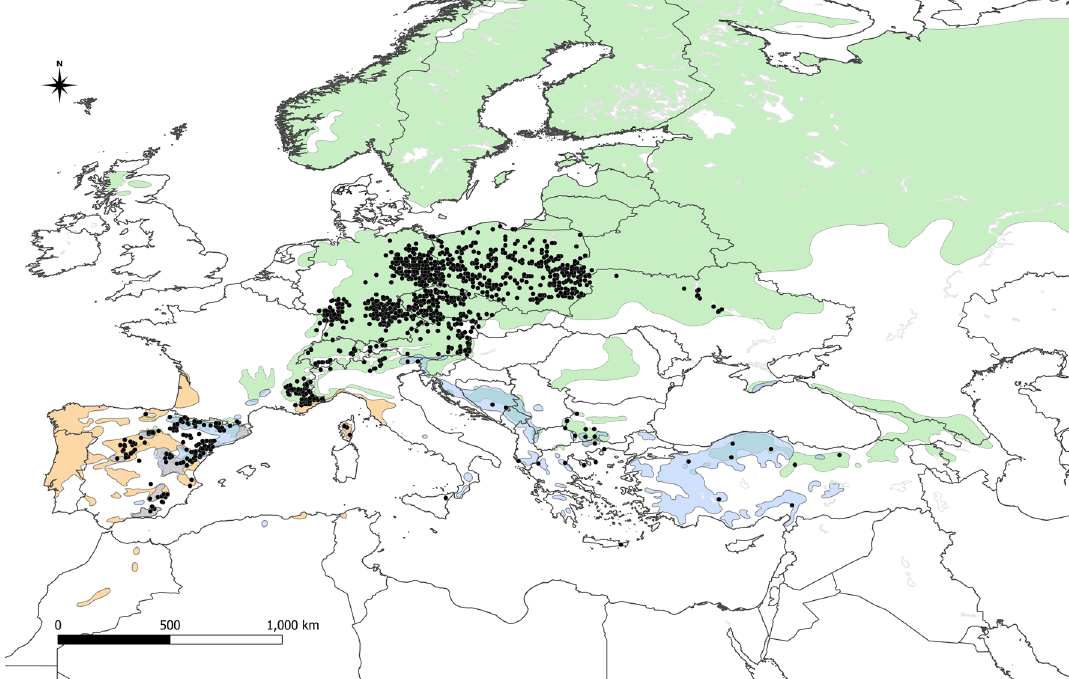
Figure 4. Stands of Viscum album subsp. austriacum used in analyses (black dots) and ranges of its hosts. Green—natural range of Pinus sylvestris ; orange—natural range of P. pinaster; blue—natural range of P. nigra (Caudullo et al. 70